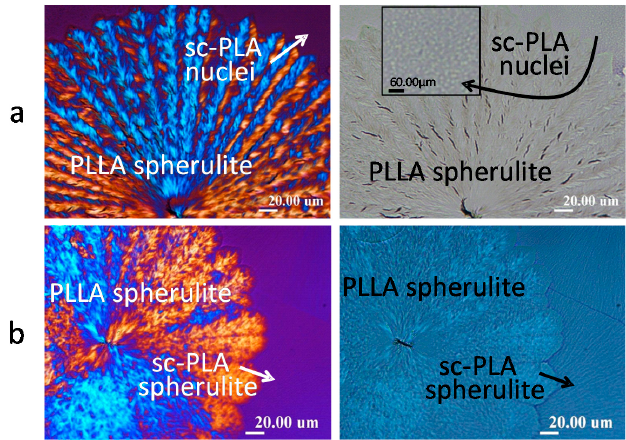
Figure 6. POM ( left ) and OM ( right ) morphology of PLLA/PDLA (90/10) samples subjected to ( a ) T max = 190 °C then T c = 140 °C, in comparison to ( b ) T max = 240 °C then crystallized at T c = 140 °C, cooled to ambient and melted/recrystallized again at T max = 190 °C and T c = 140 °C. Reproduced with permission from Ref. [19].